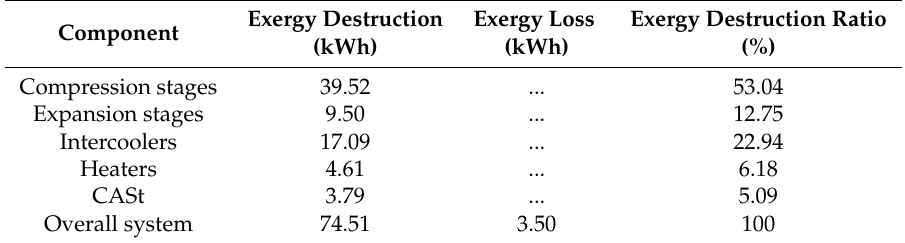
Table 9. Total exergy destruction and exergy destruction ratio of each component for a complete cycle of charge and